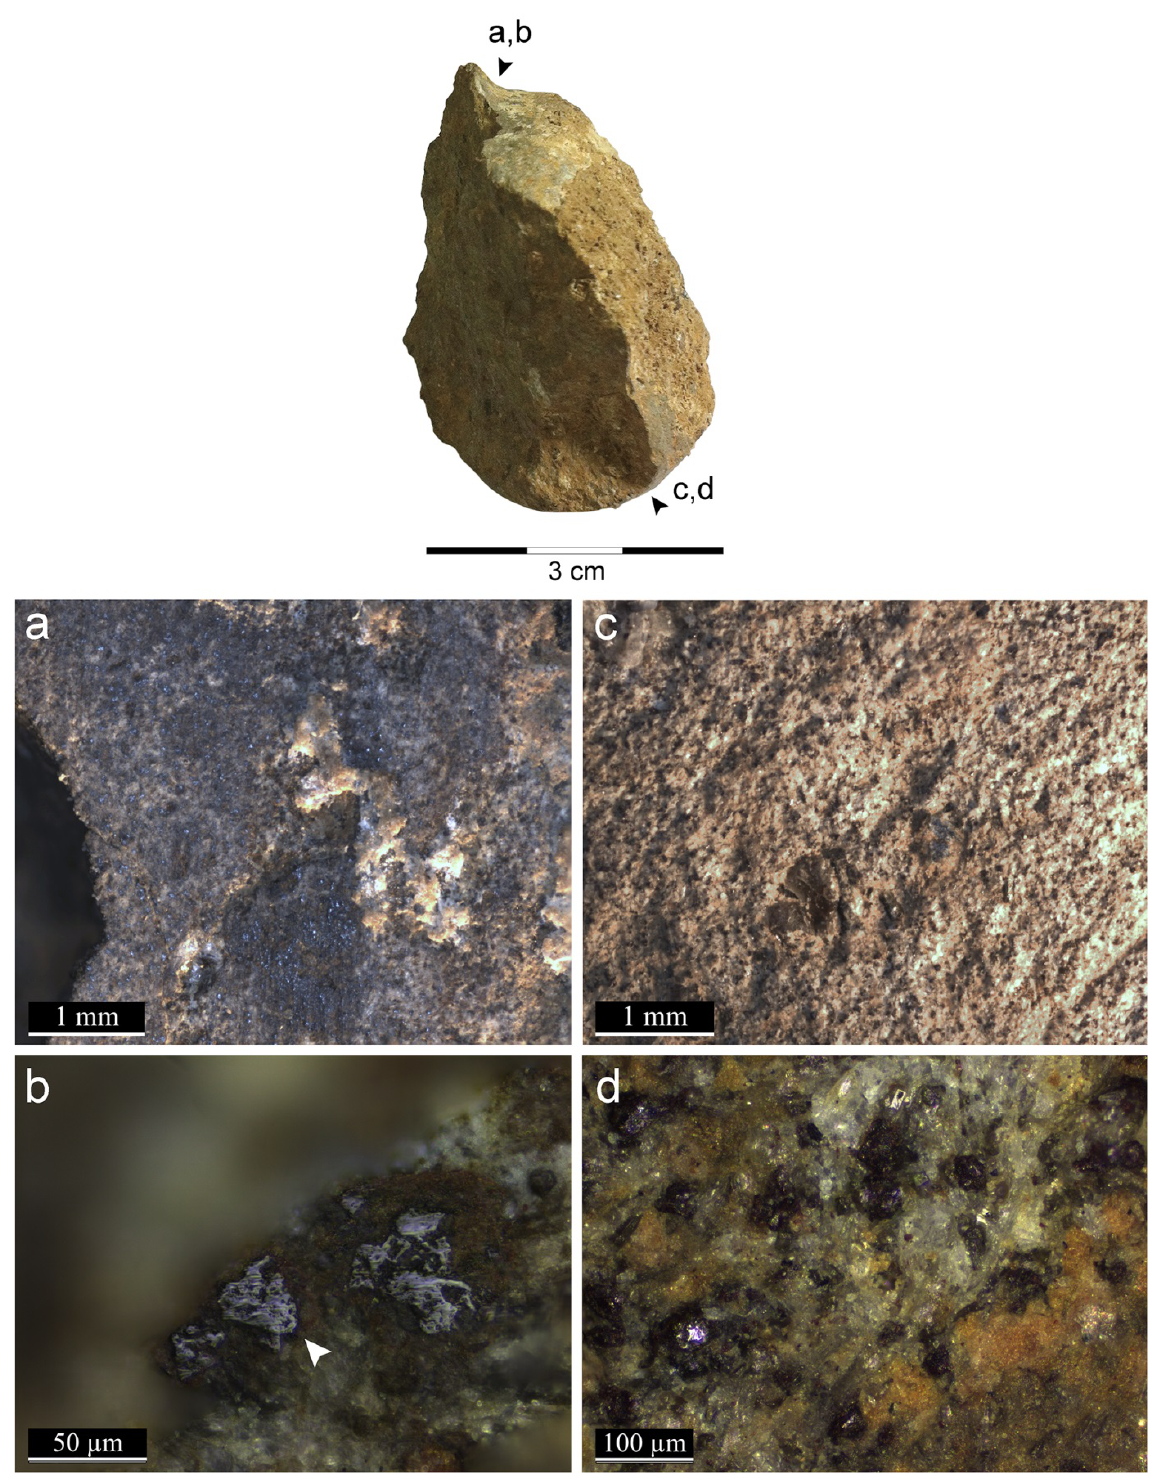
Figure 5: Side view of artefact number 176 showing the concave bottom of the groove and walls extending outward. Locations of microphotographs are indicated by arrows. Traces inside the groove interpreted as having been produced by contact with a medium hardness material such as bone, wood or reeds: a) wide flattened surface associated with pits and shallow grooves extending parallel to the main axis of the groove (x20), b) micro-polish developed on protruding phenocrysts indicated by the white arrow exhibiting directionality pattern of abrasion along the main axis of the groove (x500) (similar polish was observed on artefact number 177, see Figure 6b). Traces on the perimeters interpreted as having been produced by contact with a hard stone: c) extremely flat peaks with sharp edges (x20), d) rough bright polish developed on protruding points indicated by the white arrows